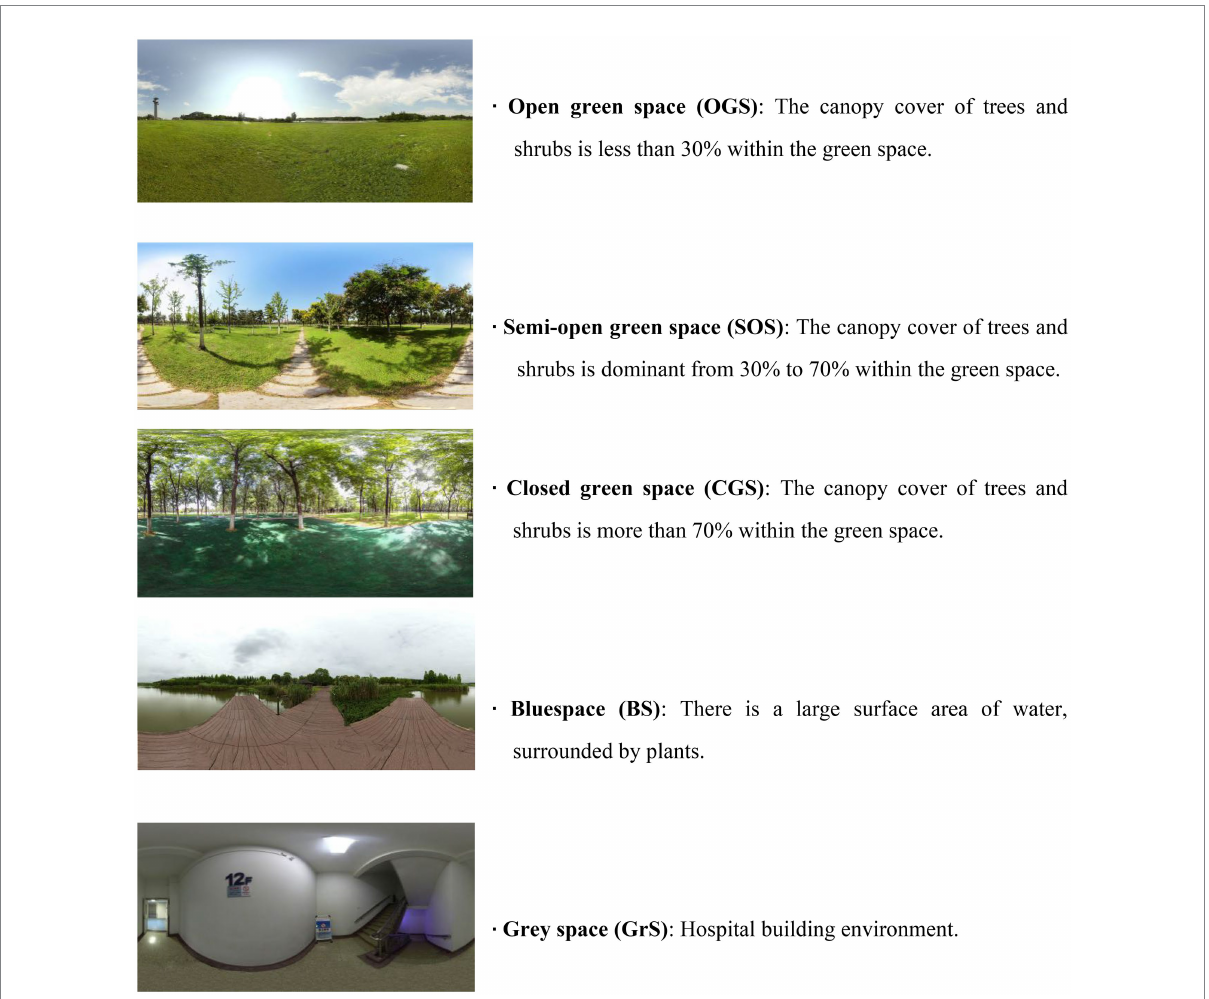
FIGURE 1 The representative panoramic photographs and description of the five typical types of environment identified by experts according to land cover, canopy cover ratios, size, location, species composition, setting configuration, and management regime. The intervention group viewed various green and blue spaces while the control group viewed the gray